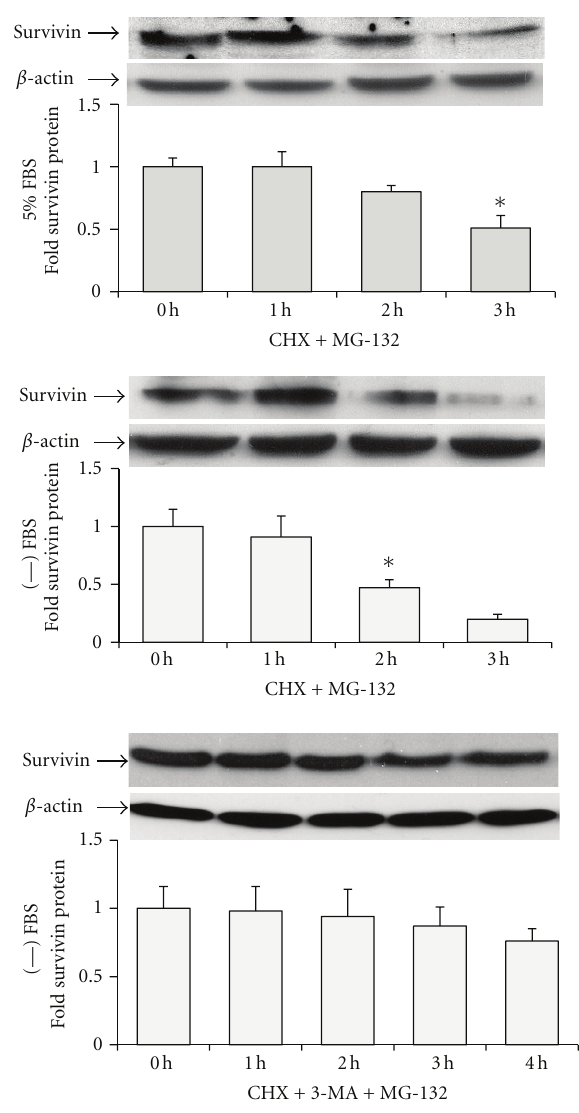
Figure 6: Survivin protein is degraded by ubiquitin proteasome in serum-free and serum-containing media. Western blots and protein quantitation graphs showing that addition of MG-132 proteasome inhibitor (10 μ M) extended survivin protein half-life in serum- free and serum-containing media. One representative western blot out of triplicate experiments was shown for each treatment and condition. ∗ Indicates the time at which survivin protein is half of the amount at 0 hours (half-life), P < 0 . 02.